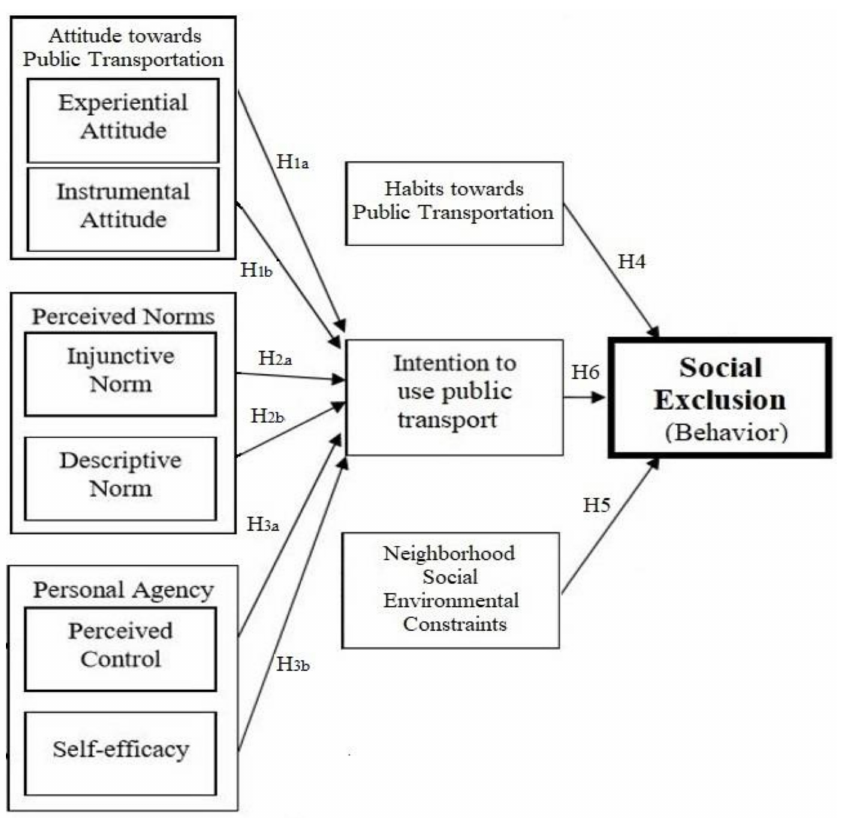
Figure 1. Conceptual framework of the study adapted from the Integrated Behavioral Model